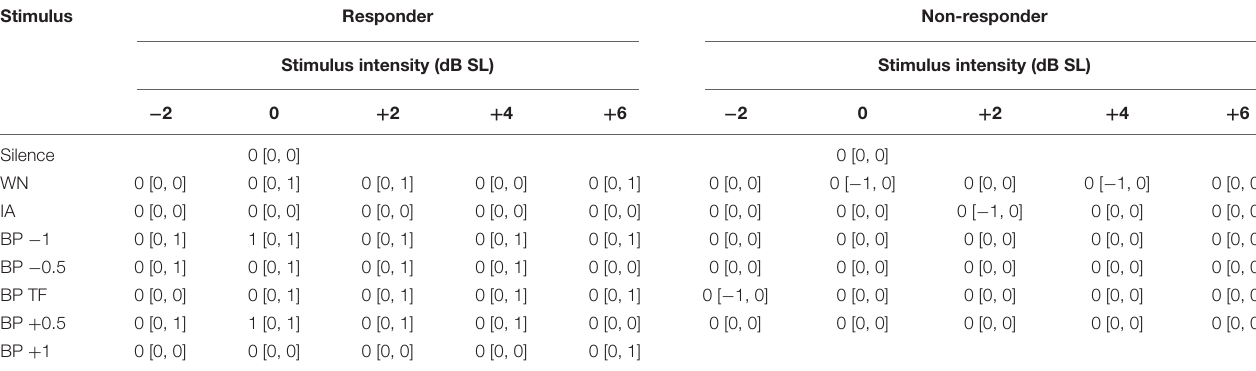
TABLE 1 | Median responses [interquartile range] to noise stimuli of R and NR patients.